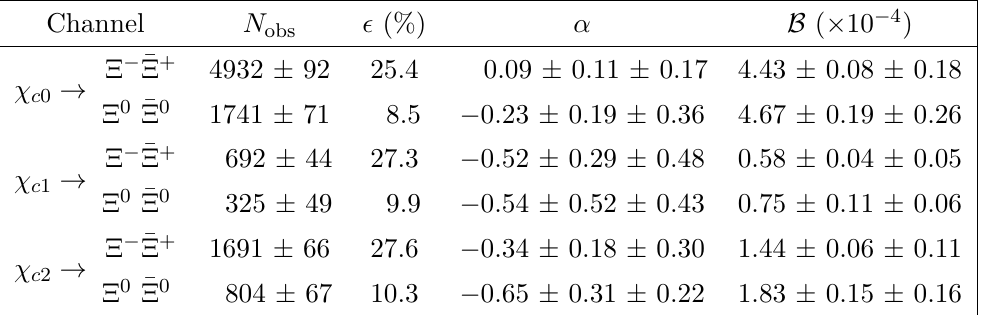
Table 1 . The measured branching fractions B and decay parameters α for the χ cJ → Ξ − ¯ Ξ + and χ cJ → Ξ 0 ¯Ξ 0 processes, where N obs is the number of signal events and (cid:15) is the detection efficiency. The first uncertainty is statistical and the second is